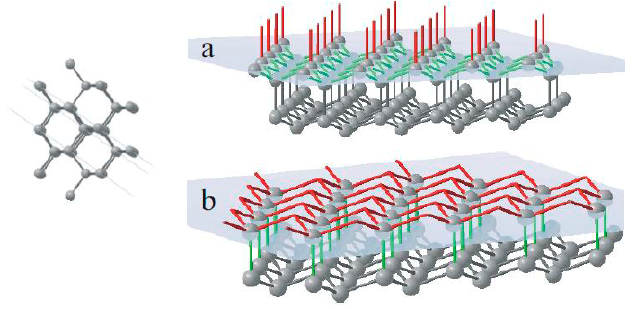
Figure 5. Atomic plane of octahedral face. ( a )—layer of single-bond units; ( b )—layer of triple-bond units.